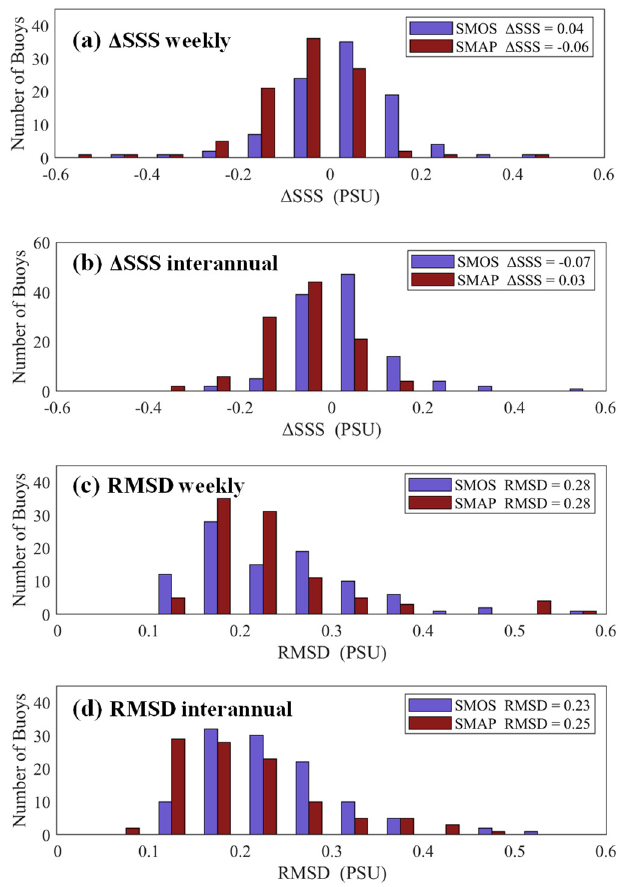
Figure 14. Histogram of Δ SSS and RMSD between SMOS BEC global L3 product (purple), SMAP JPL product (dark red), and GTMBA buoy salinity at 1 m. ( a ) Weekly Δ SSS, ( b ) interannual Δ SSS, ( c ) weekly RMSD, ( d ) interannual RMSD. The numbers in the top right legend are the corresponding average Δ SSS ( a,b ) and RMSD ( c,d ) values.